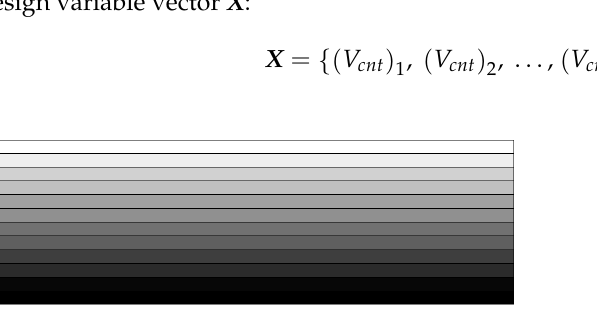
Figure 2. Division of an FG-CNTRC beam into uniform homogenized sub-layers.